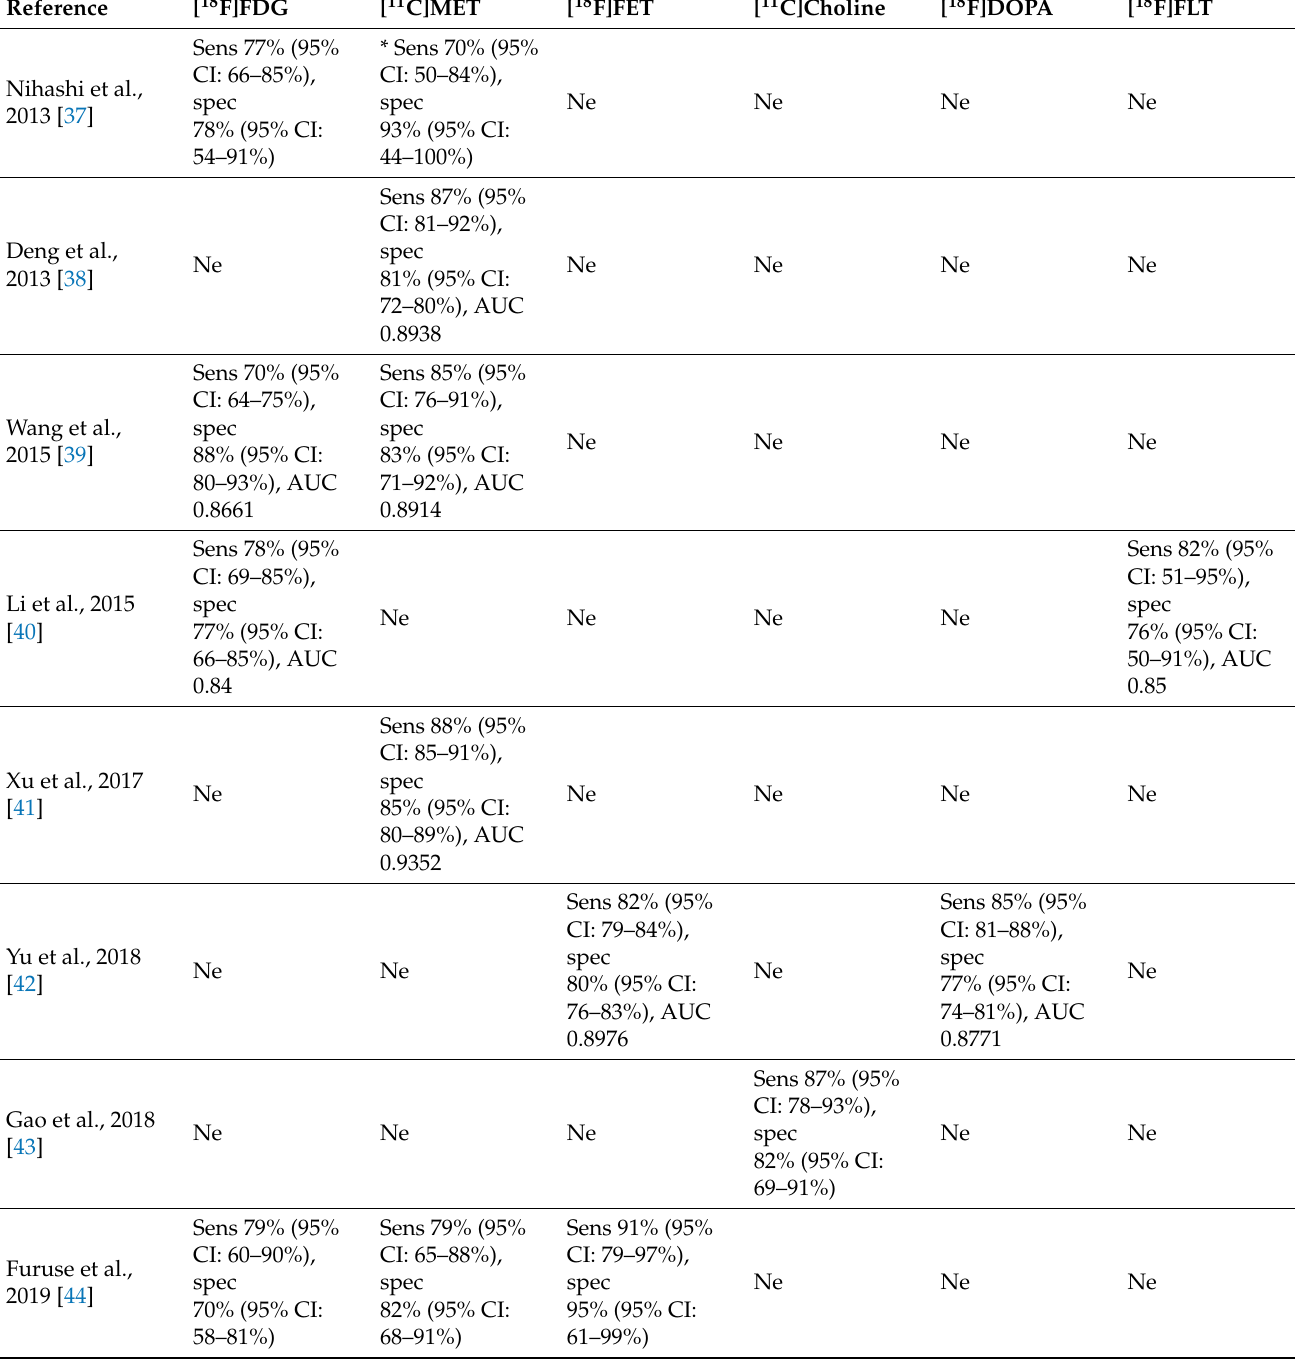
Table 6. Summary of the main results of meta-analyses evaluating the role of PET in the differential diagnosis between radiation necrosis and disease recurrence in glial